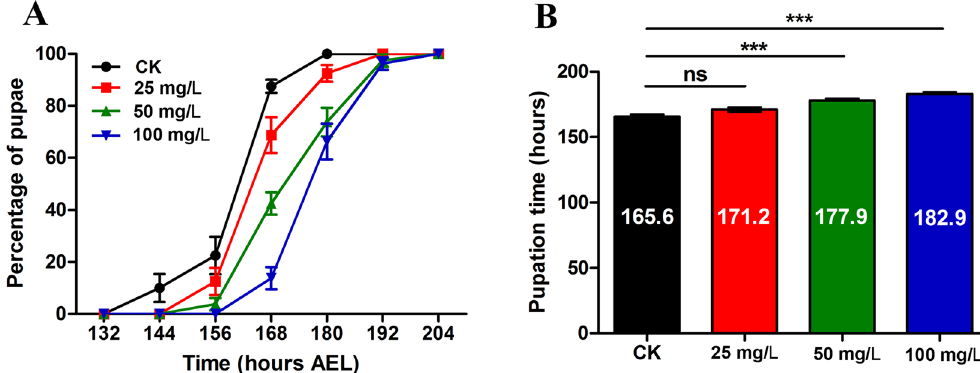
Figure 2. Effects of XP-1408 on pupariation of the third instar Drosophila larvae. ( A ) The larvae developmental curves were drawn based on the pupation in different time points after treated with 25, 50 and 100 mg/L of XP- 1408. n = 20 larvae, four repetitions. ( B ) The total pupation time was counted from the data in CK and XP-1408 groups with different concentration. *** P < 0.001vs. CK. ns, not